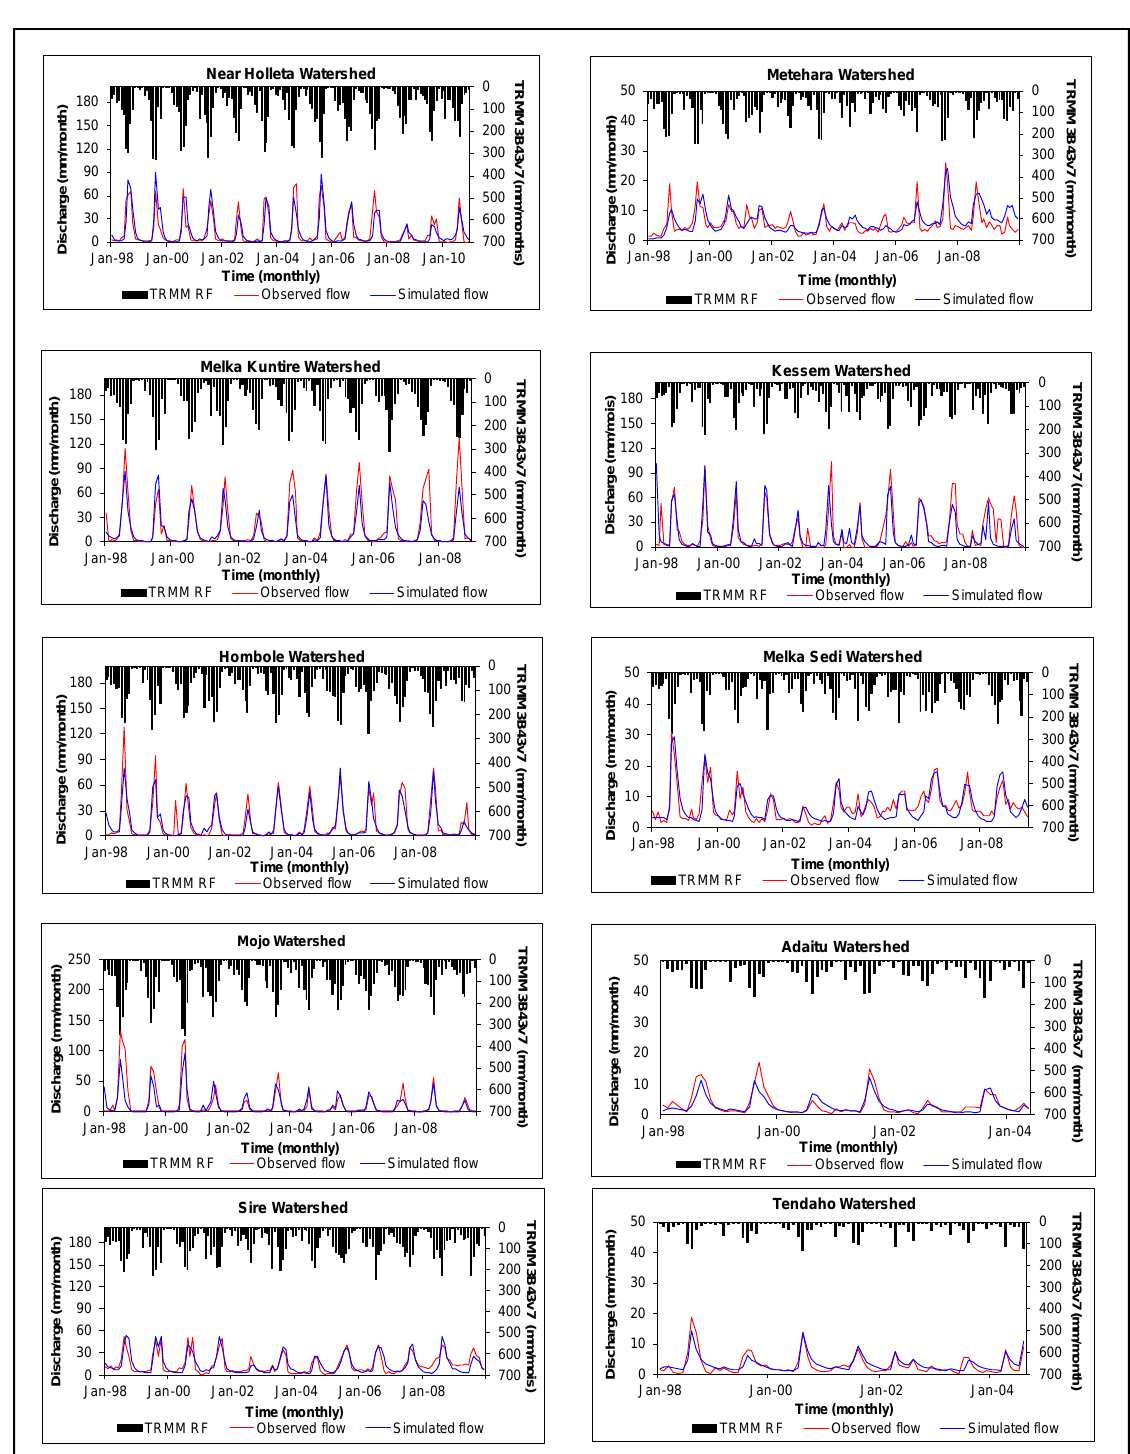
Figure 8. Calibration and validation procedure using Tropical Rainfall Measuring Mission (TRMM 3B43v7) rainfall and gauged streamflow records of the ARB.